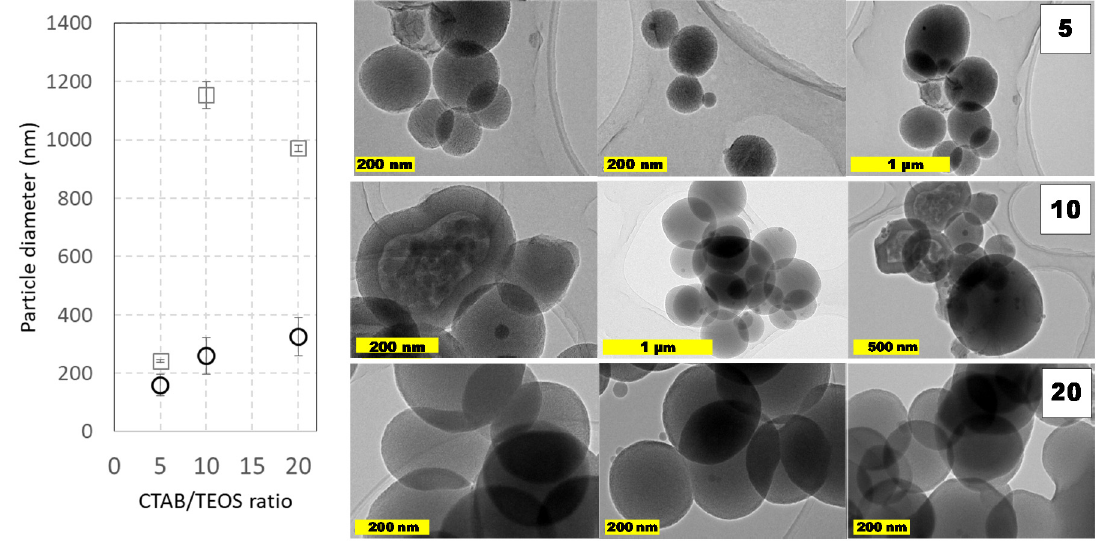
Figure 4. Particle size distributions and TEM images of prepared MCM-41 MSNs at varying TEOS/CTAB ratios. Squares ( ) are used for hydrodynamic diameters measured by DLS values and circles ( ) for diameters obtained from TEM micrographs. Experimental conditions: 1 L round-bottom flask reactor with 0.5 L working volume and magnetic stirring (800 rpm). Reactions were carried out at pH ≈ 11.8 (adjusted upon addition of 0.28 g NaOH) at 80 °C using TEOS (5 mL, 0.5 mL·min -1 ) and CTAB (1 g, 2 g ⋅ L -1 ) during a 60 min. Data shown correspond to samples D3, D5, and D7 in Supplementary material. Numbers on micrographs indicate the CTAB/TEOS ratio employed on each synthesis.